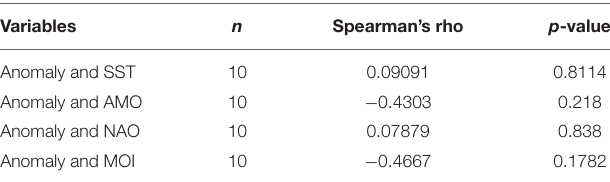
TABLE 5 | Spearman’s rank-order correlations of the primary production anomaly with sea surface temperature (SST), the Atlantic Multidecadal Oscillation index (AMO), the North Atlantic Oscillation index (NAO), and the Mediterranean Oscillation index (MOI).